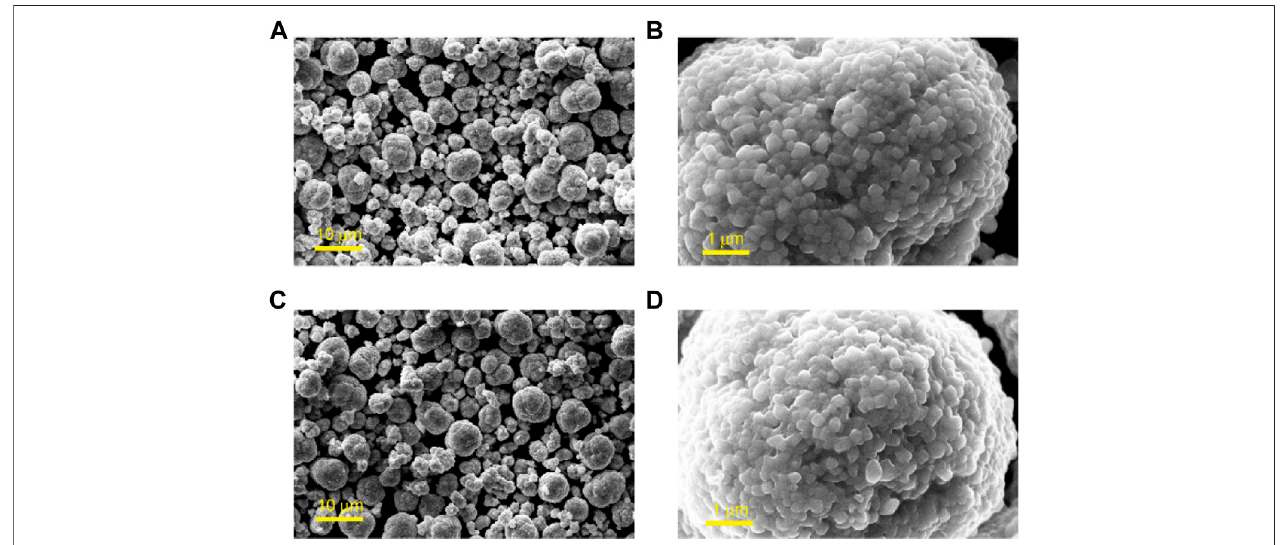
FIGURE 1 | SEM images of Li 1.1 Ni 0.35 Mn 0.55 O 2 (A,B) pristine particles in different magni fi cations; and (C,D) particles with Li 4 Ti 5 O 12 coating in different magni fi